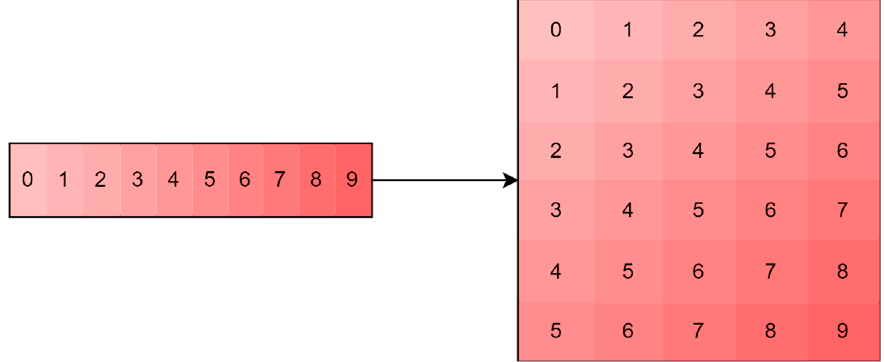
Figure 4. Example of sliding window application ( 𝑙 = 5 ) for a vector of numbers from 0 to 9.